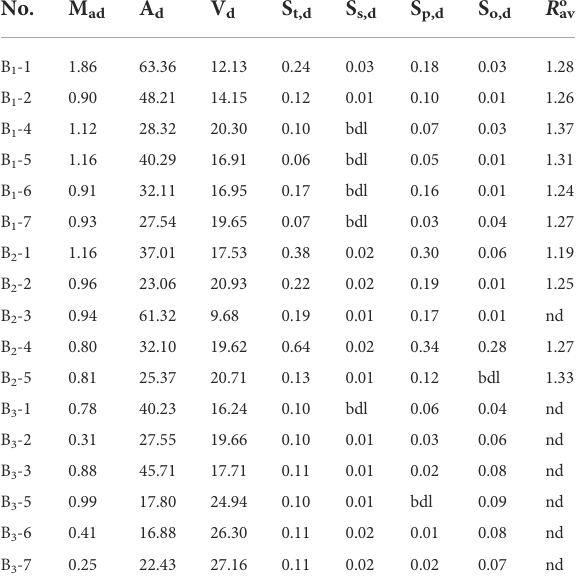
TABLE 1 Partial proximate analysis, sulfur contents and vitrinite re fl ectance in coals from the Yantang Mine in Xuanwei, Yunnan